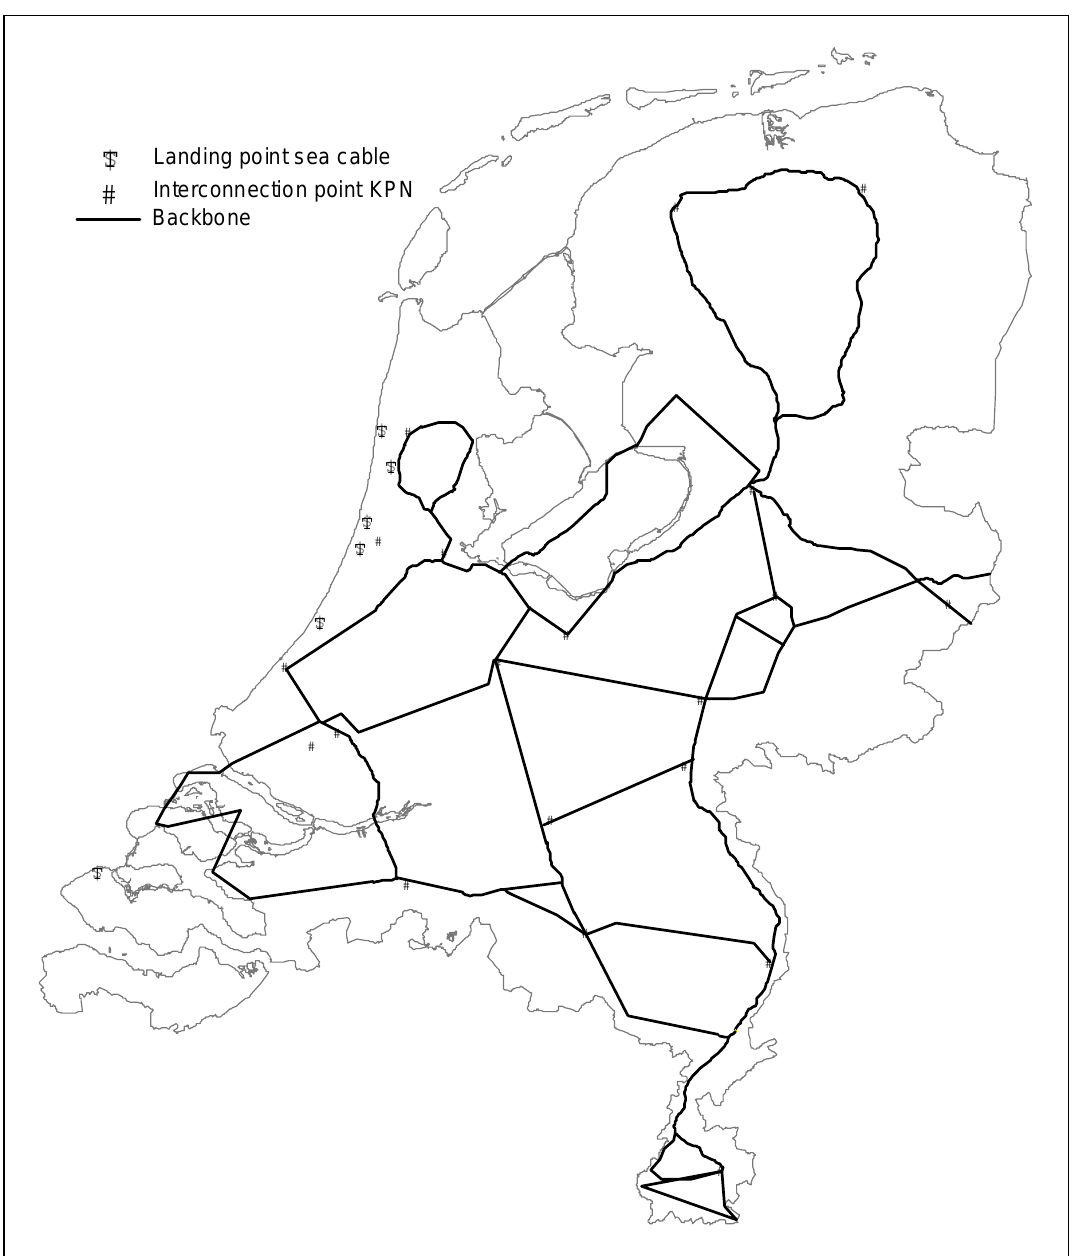
Figure 7. Main ICT-infrastructure in the